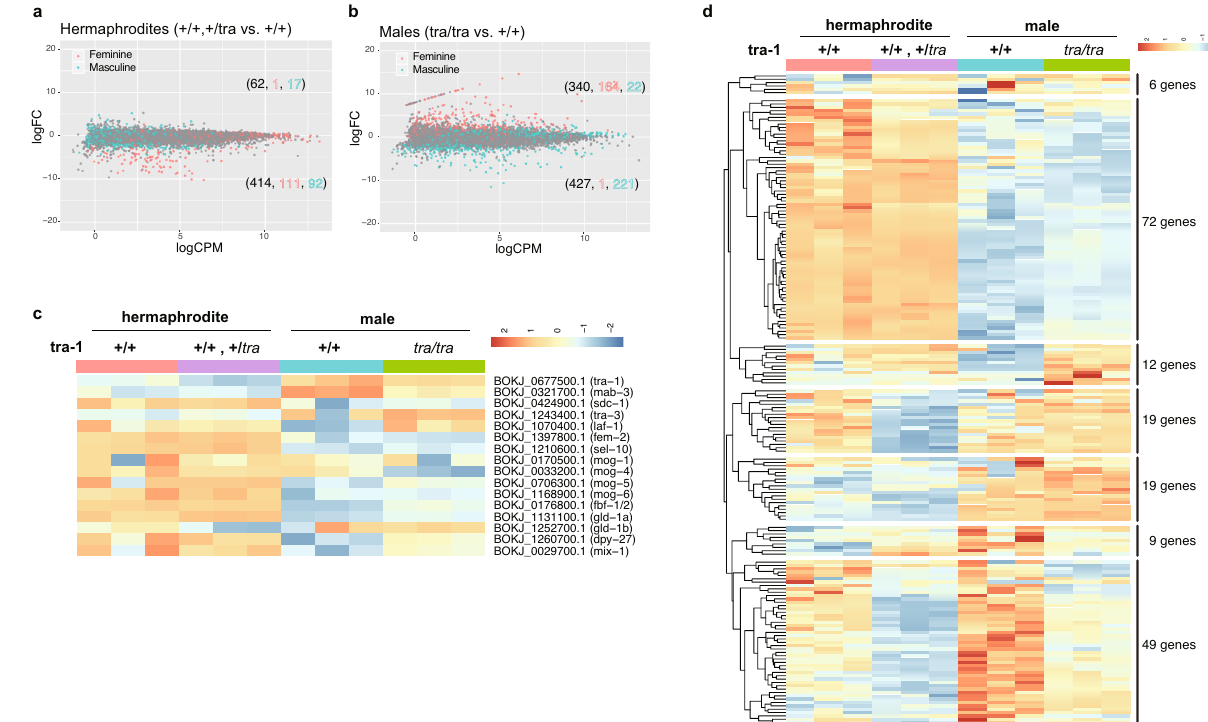
Fig. 6 Gene expression in the Bok-tra(sy867) mutant. Summary of differential gene expression in the tra-1 mutant compared to wild-type for B. okinawaensis hermaphrodites ( a ) and males ( b ). LogCPM and logFC represent the logarithm of counts per million reads and the log-transformed fold change in gene expression, respectively. Each dot represents the expression of one gene. The numbers of upregulated and downregulated genes in the tra-1 mutant are shown in parenthesis. Feminine and masculine genes detected by a comparison of wild-type hermaphrodite and male (see Supplementary Fig. 10) were shown in red and blue, respectively. c Gene expression of B. okinawaensis orthologues of genes involved in sex determination and dosage compensation (see Fig. 3). d Gene expression of B. okinawaensis orthologues of genes associated with TRA-1 proteins in C. elegans